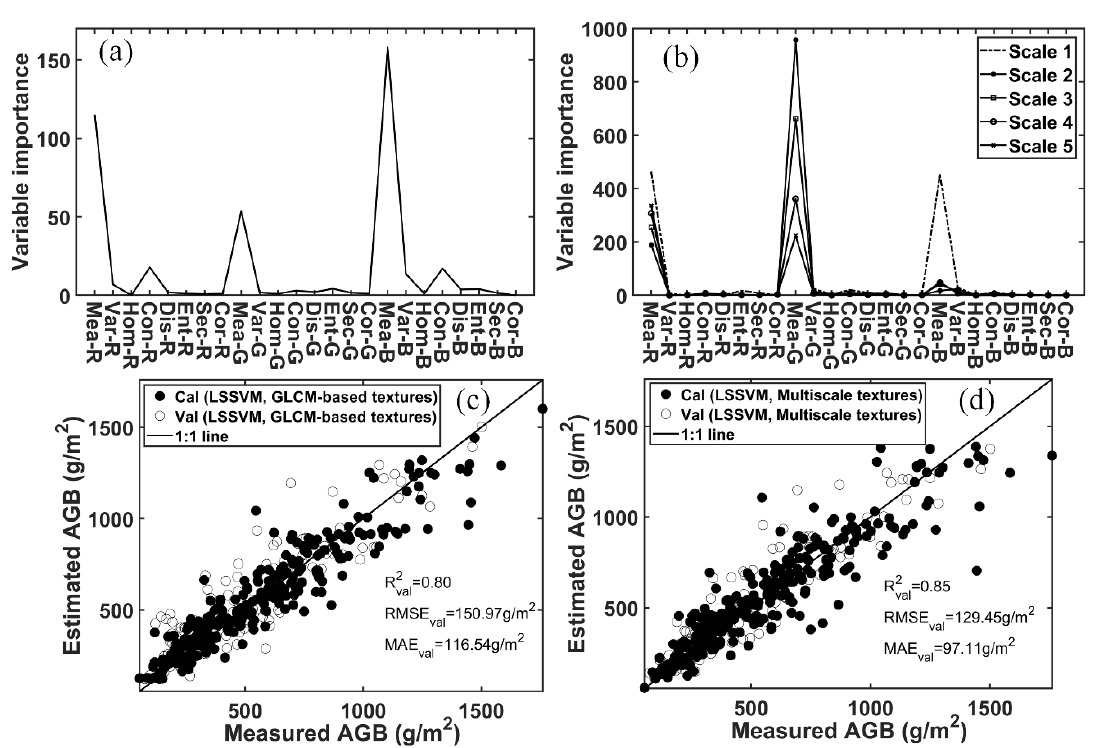
Figure 7. Predictive performance of the LSSVM regression models based on the selected GLCM-based textures ( a , c ) and selected multiscale textures ( b , d ) for winter wheat AGB estimation.